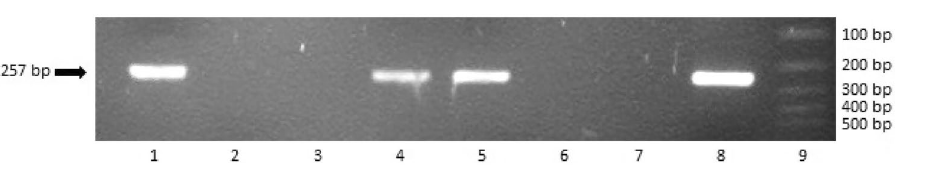
Figure 2. Image of gel electrophoresis of MS-PCR products. 1, 4, 5—methylated samples, 2, 3, 6— unmethylated sample, 7—negative control (unmethylated), 8—positive control (methylated), 9—molecular- weight size marker. Original gel is presented in Supplementary Fig.